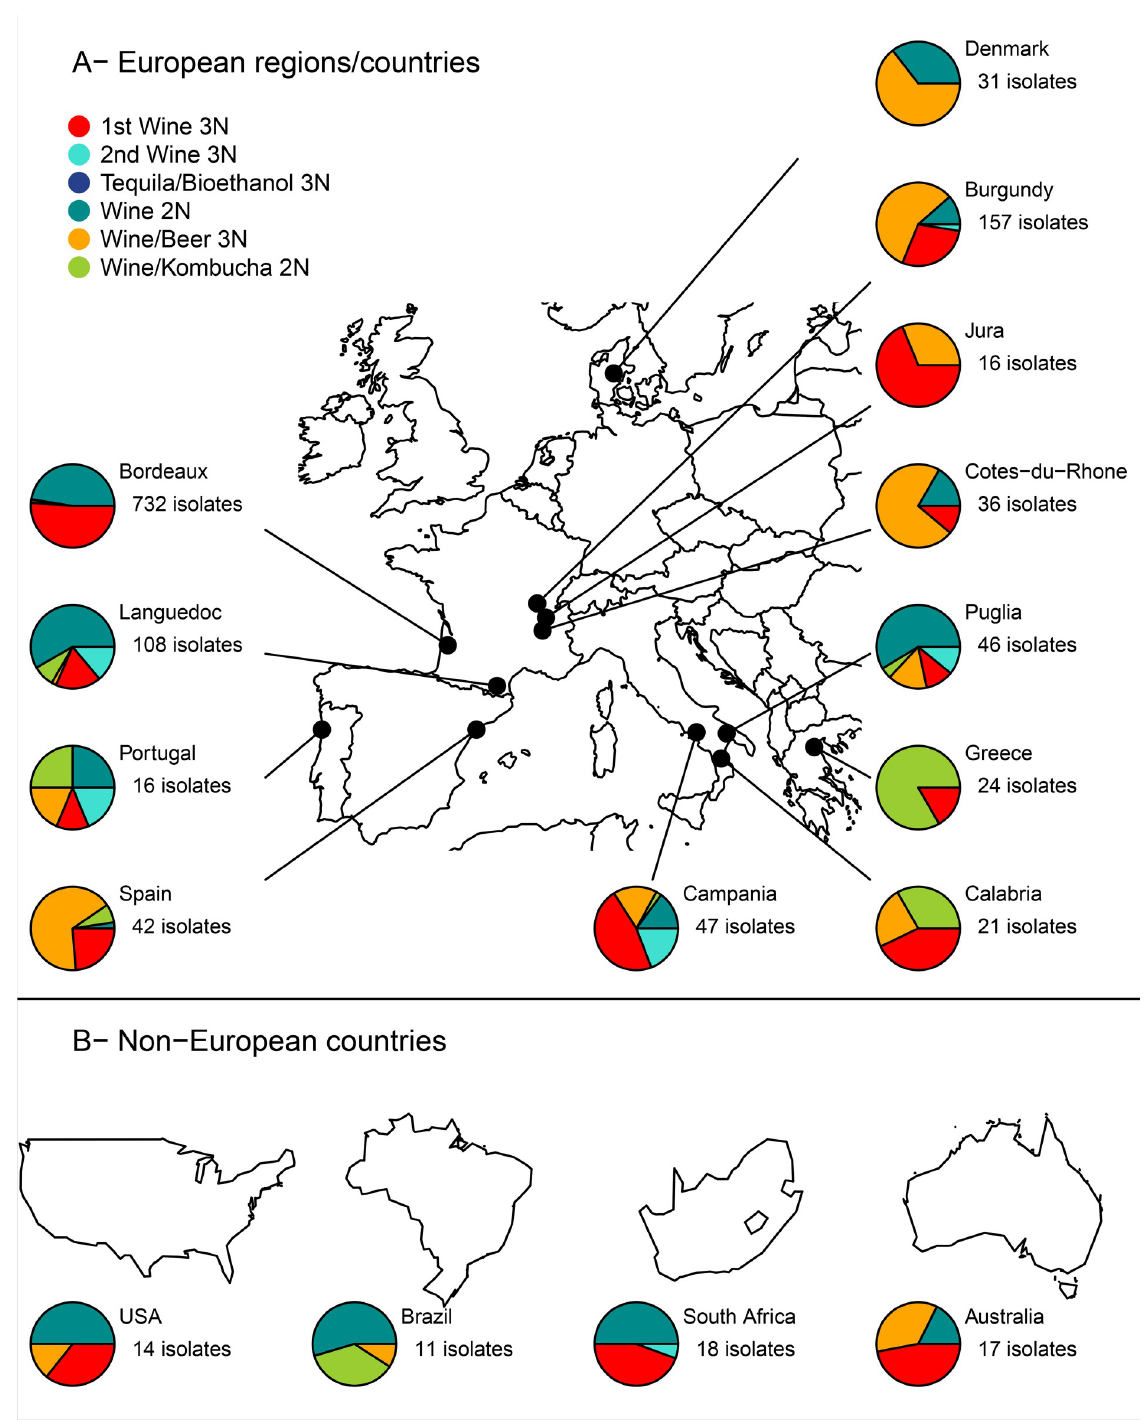
Fig 2. Genetic distribution of Brettanomyces bruxellensis wine isolates in different regions or countries. Maps were drawn using maps packages and pies using graphics package.